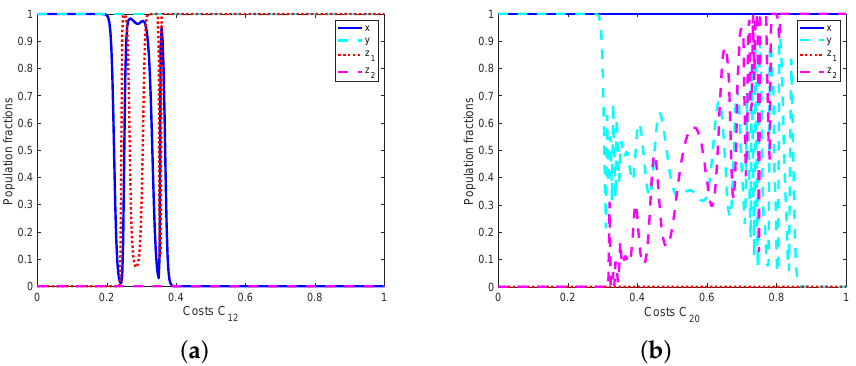
Figure 5. The impact of cybersecurity costs on the ESS E 6 . ( a ) Evolution of population fractions x , y , z 1 , and z 2 over C 12 . ( b ) Evolution of population fractions x , y , z 1 , and z 2 over C 20